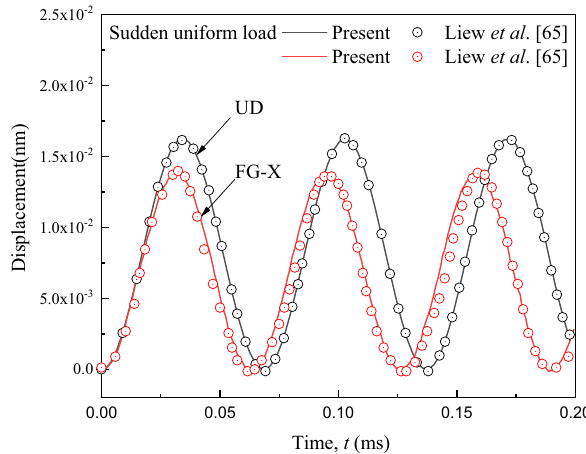
Figure 5: Comparison of forced vibration curves for UD and FG - X laminated plate.